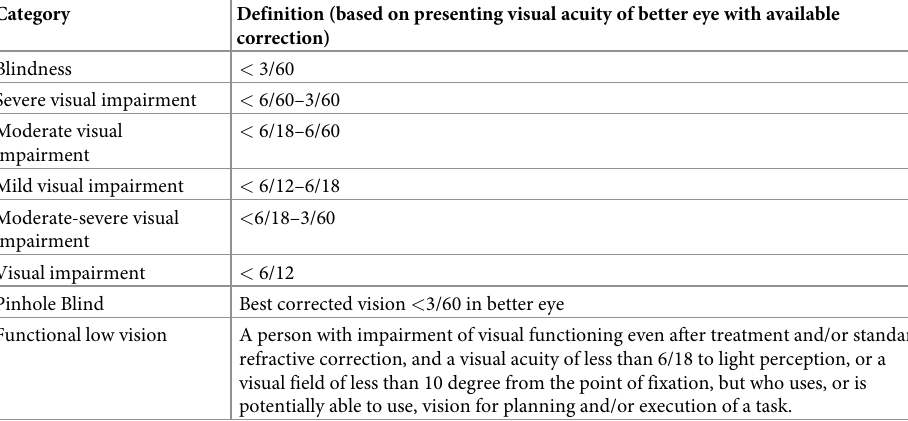
Table 1. Definitions of vision impairment used in the National Blindness and VI Survey.